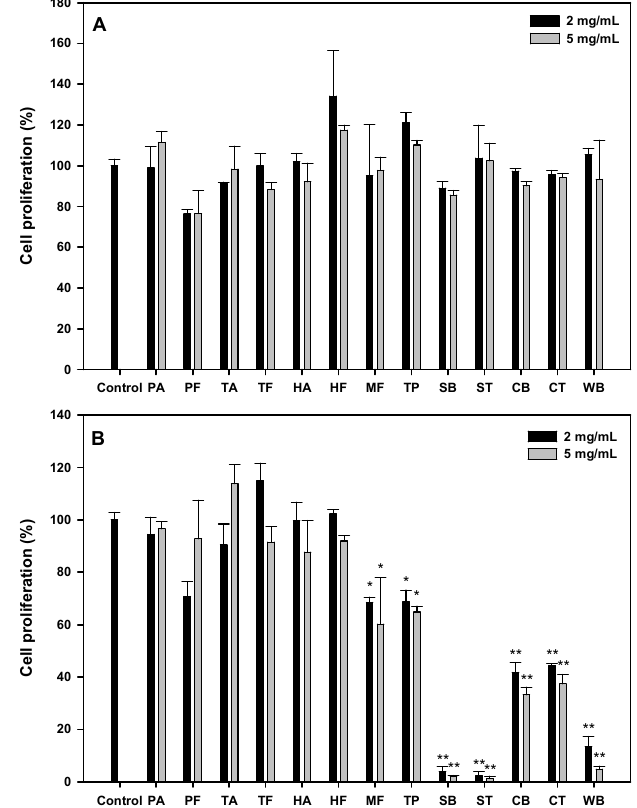
Figure 1. Cell proliferation of HSC-3 treated with various protein hydrolysates at the concentration of 2 and 5 mg/mL for 24 h ( A ) and 48 h ( B ). Data, mean ± SD (n = 3). * p < 0.05 and ** p < 0.01 against control. PA: Porcine skin gelatin/Alcalase; PF: Porcine skin gelatin/Flavourzyme; TA: Tilapia skin gelatin/Alcalase; TF: Tilapia skin gelatin/Flavourzyme; HA: Halibut skin gelatin/Alcalase; HF: Halibut skin gelatin/Flavourzyme; MF: Milkfish skin gelatin/Flavourzyme; TP: Tuna cooking juice/Protease XXIII; SB: Soy protein isolate/Bromelain; ST: Soy protein isolate/Thermolysin; CB: Sodium caseinate/Bromelain; CT: Sodium caseinate/Thermolysin; WB: Wheat gluten/Bromelain.